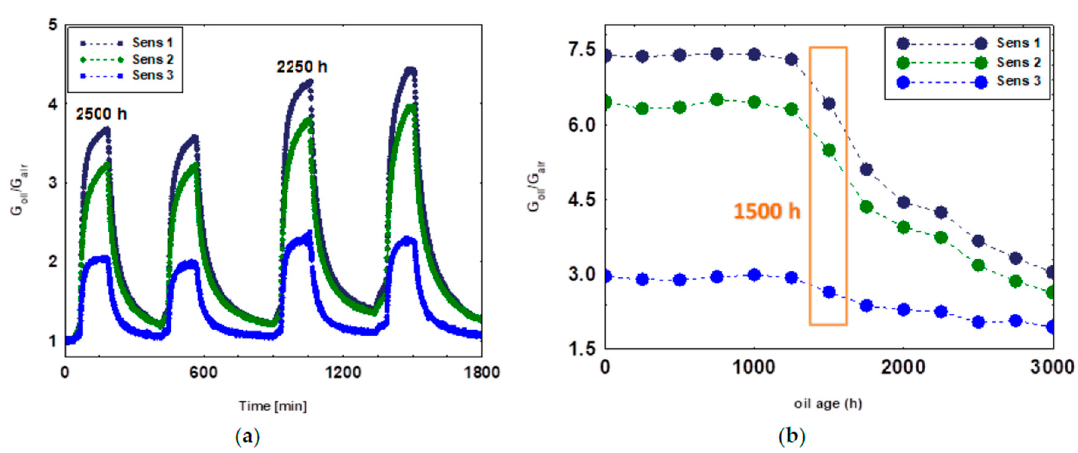
Figure 4. ( a ) Dynamic responses of three MOX sensors based on different functional materials toward the same type of oil aged 2500 and 2250 h, respectively. ( b ) Responses of the series of oil samples aged from 0 to 3000 h (step 250 h) for the same sensors of Figure